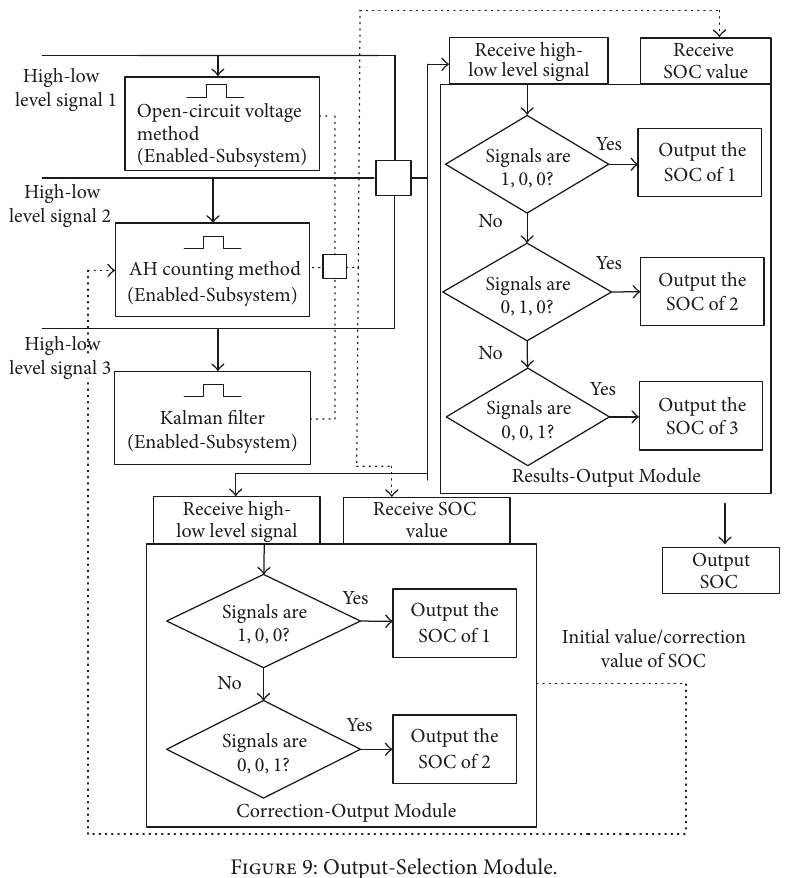
Figure 9: Output-Selection Module.